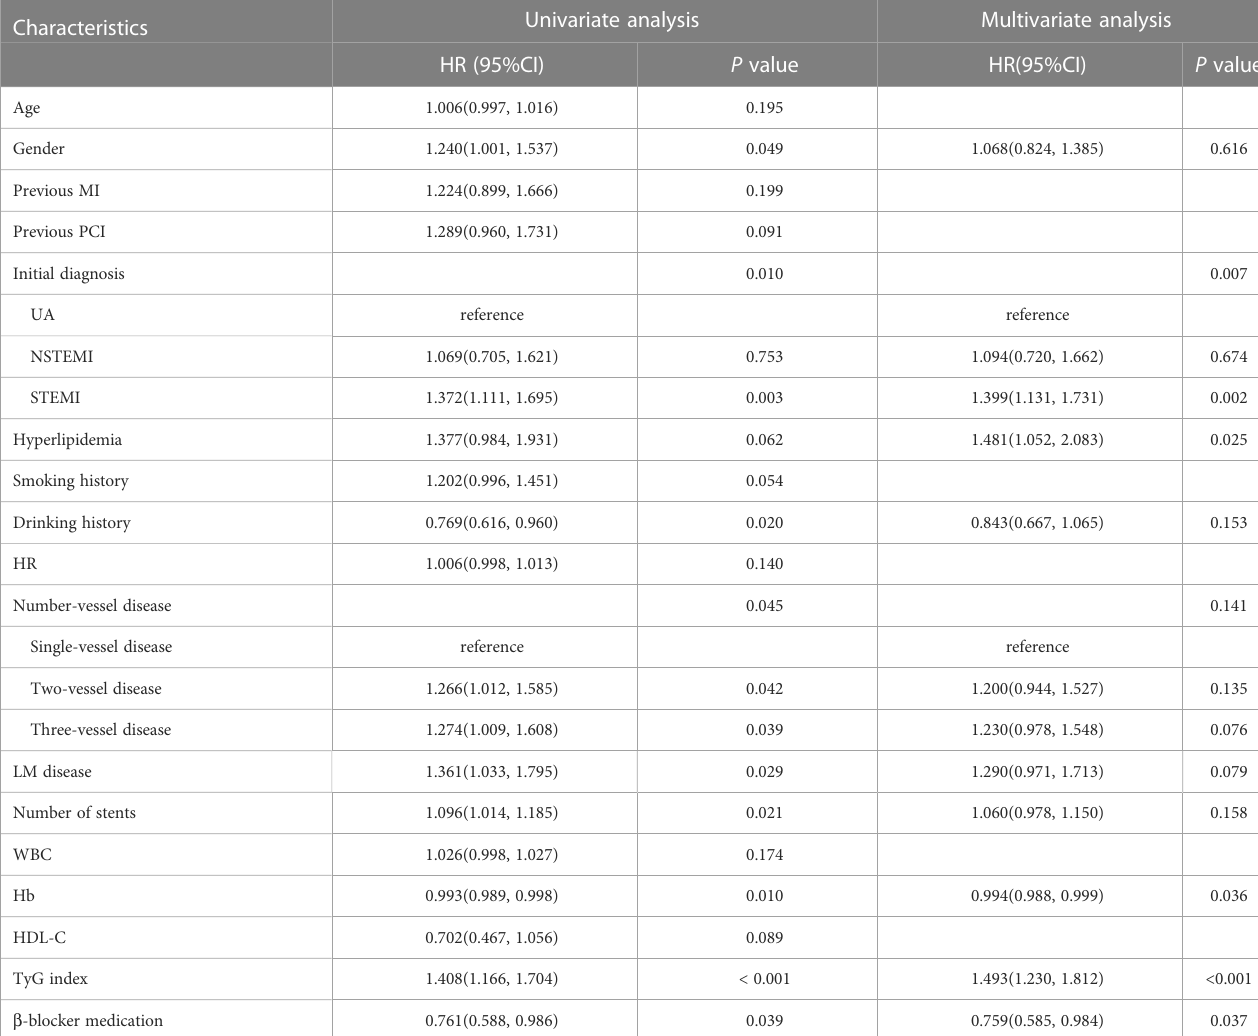
TABLE 3 Predictive value of TyG index for MACCE in univariate and multivariate